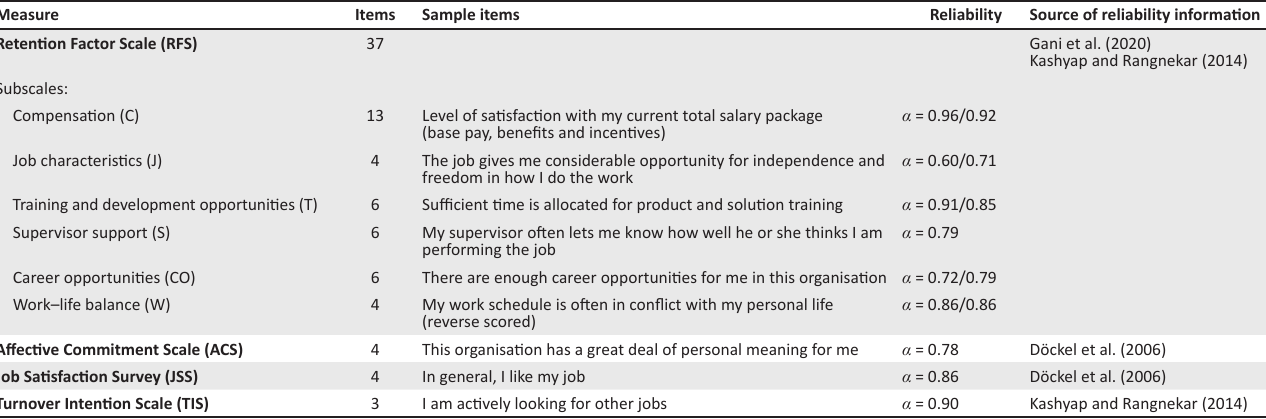
TABLE 1: Summary of measurement instruments